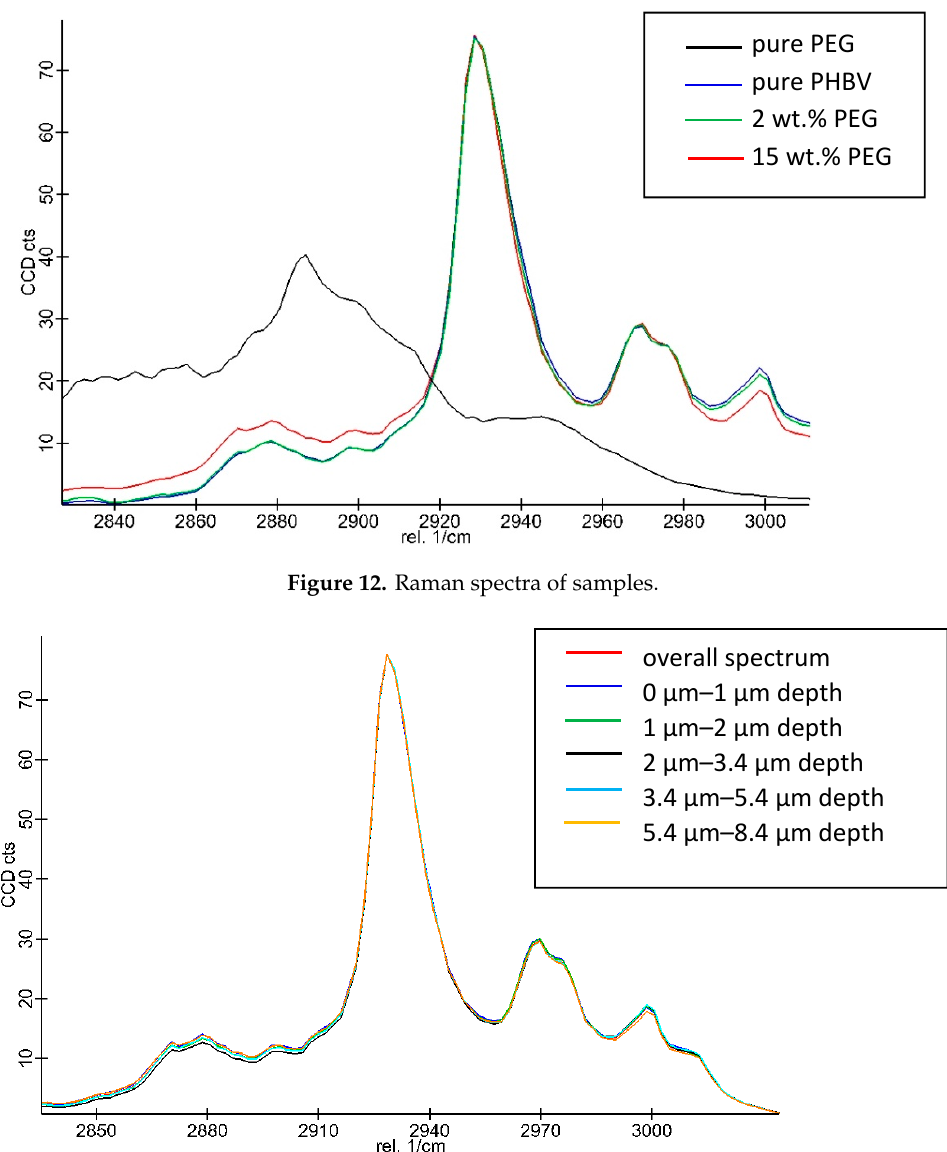
Figure 13. Raman spectra of PHBV with 15 wt.% PEG at different sample depths.